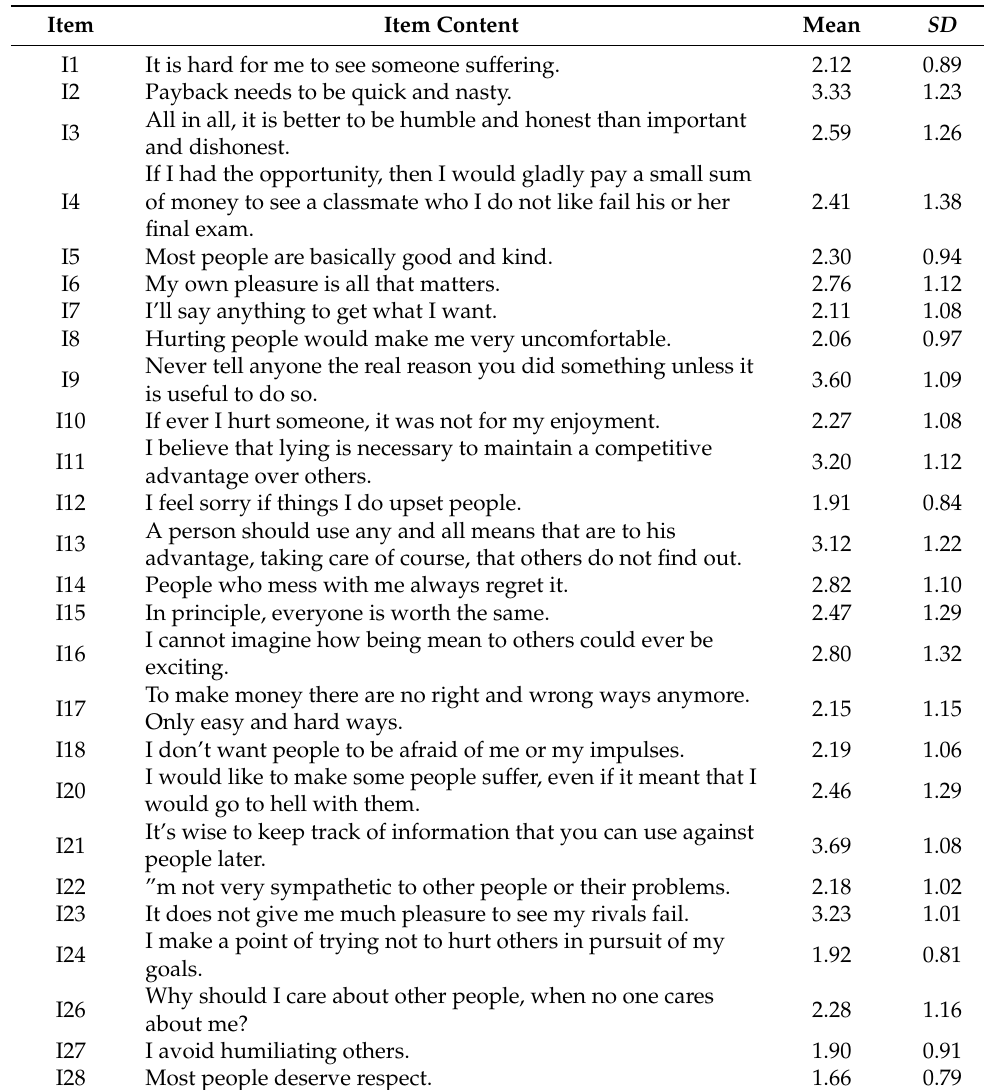
Table 2. Mean scores and standard deviation for the 32-item D